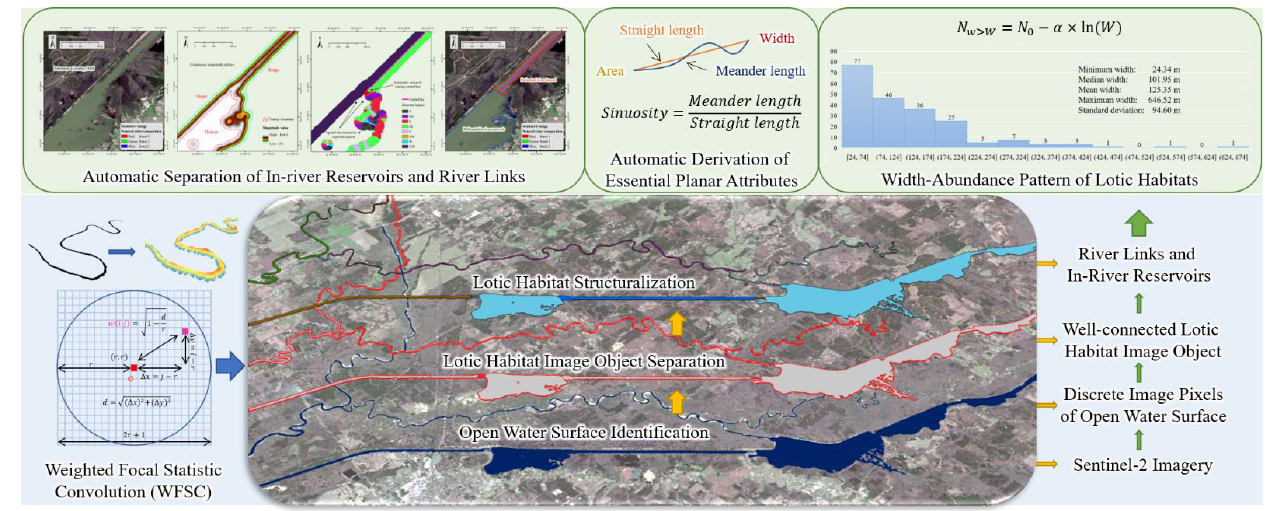
Figure 2. Flowchart of the structuralization method using